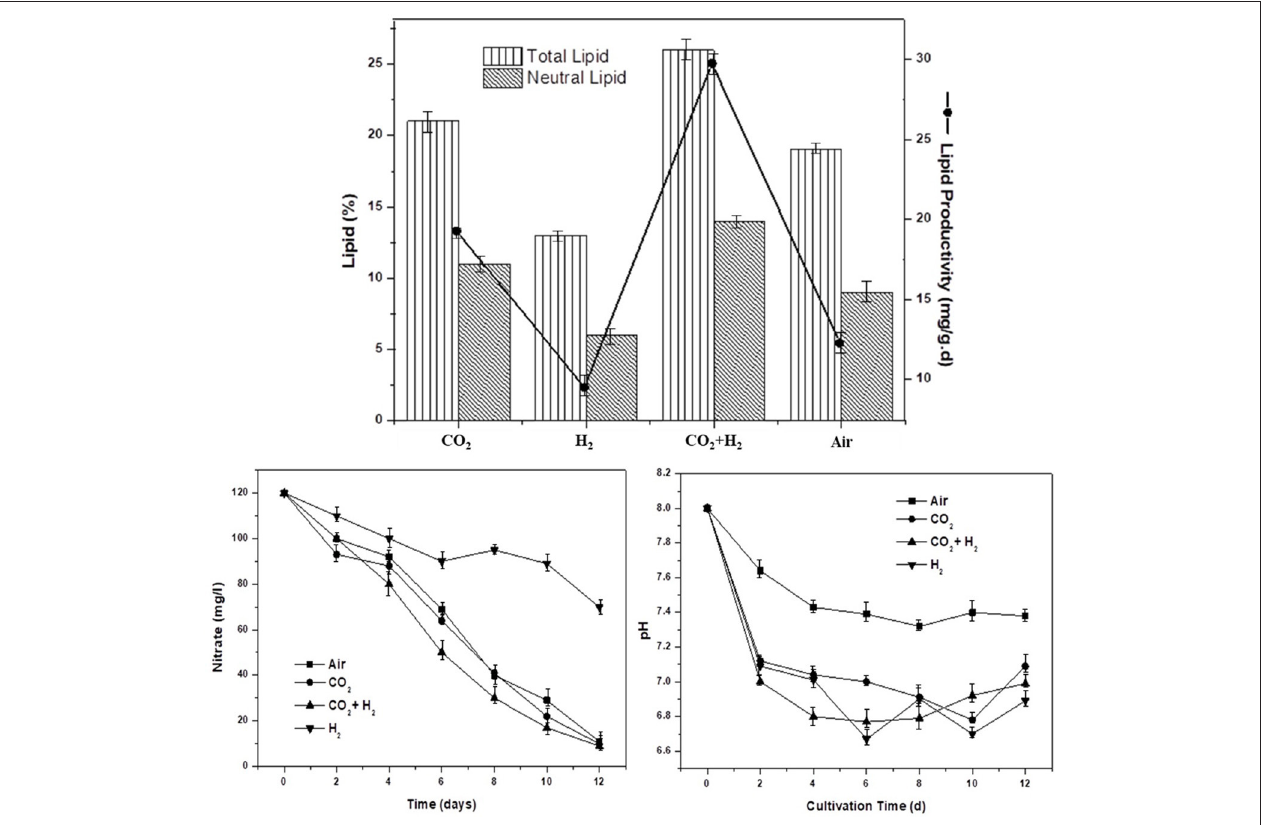
FIGURE 4 | The total lipid and neutral lipid contents in the dry biomass at the end of the cycle along with specific lipid productivity (mg.g − 1 .d − 1 ) under nutrient and redox stress are depicted for the varied gas concentrations in the headspace.